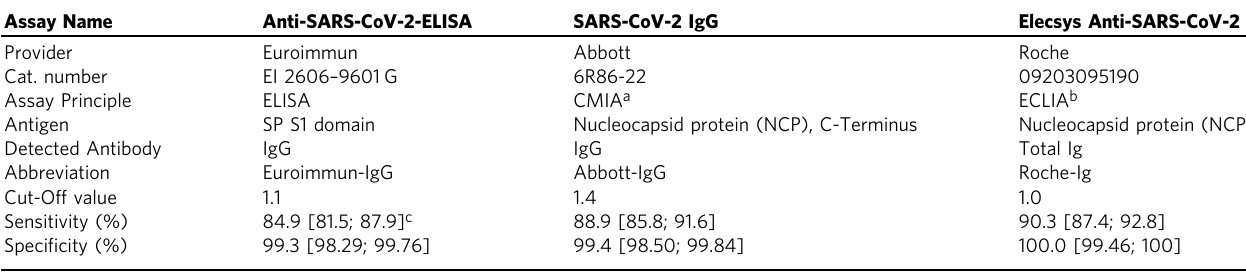
Table 1 Anti-SARS-CoV-2 antibody